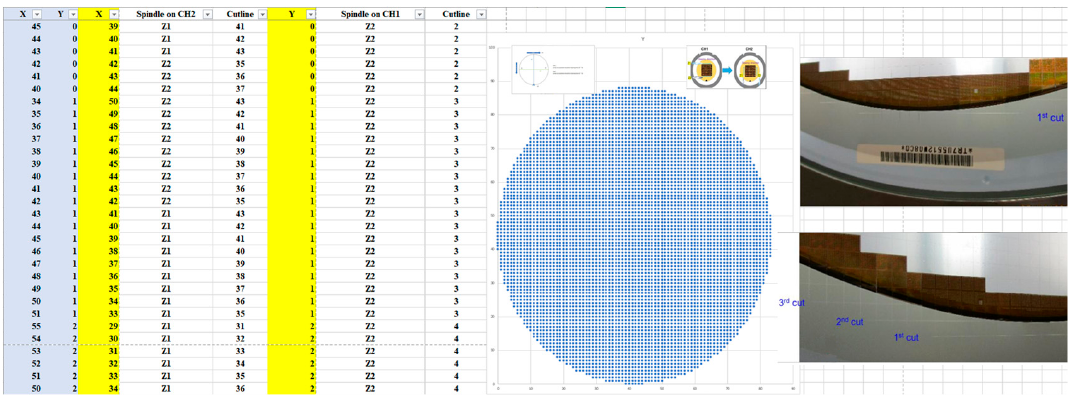
Figure 9. Cutline, channel number, and blade number of each coordinate.